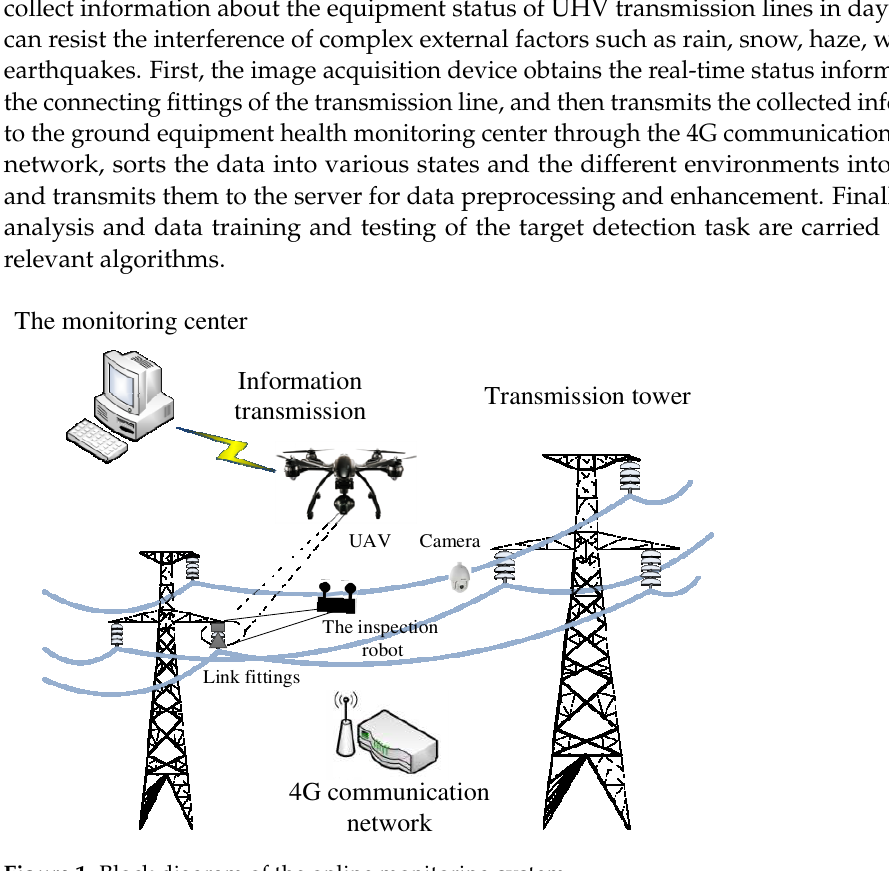
Figure 1. Block diagram of the online monitoring system.